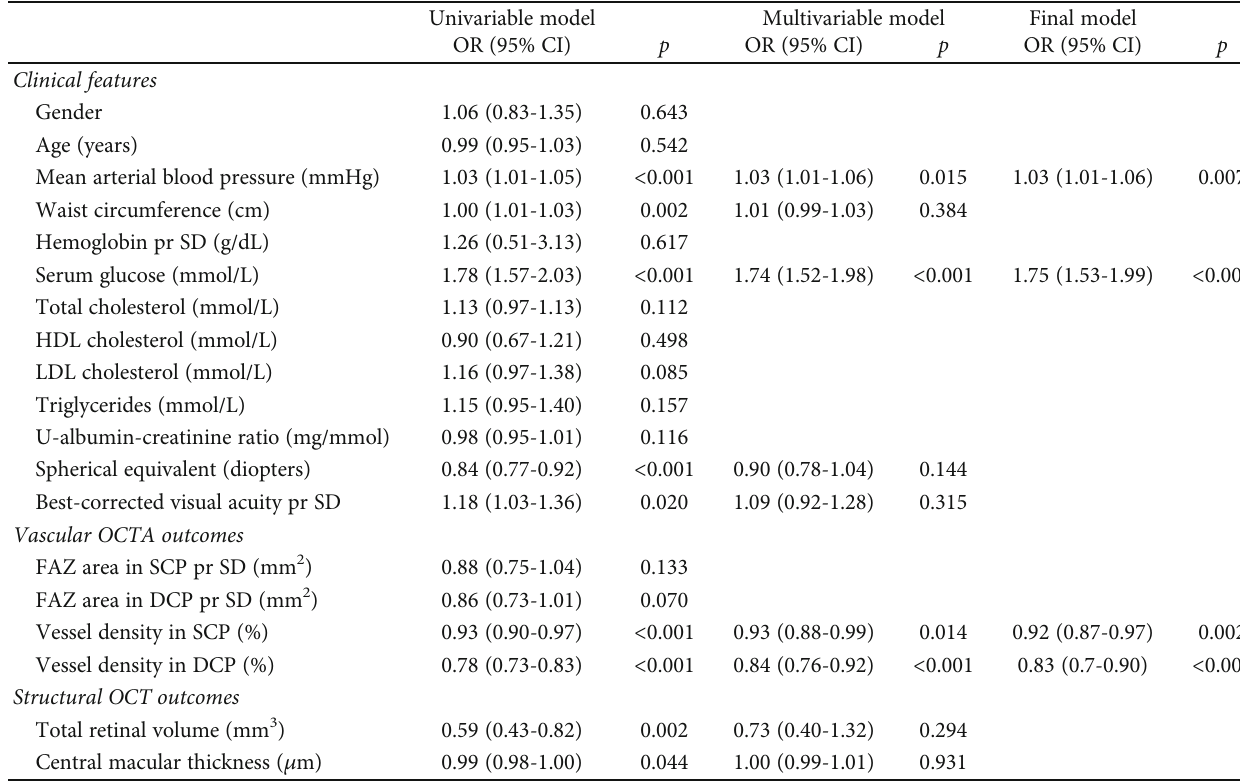
Table 3: Association between clinical risk factors and OCTA parameters in T1D patients without retinopathy vs. controls calculated by GEE